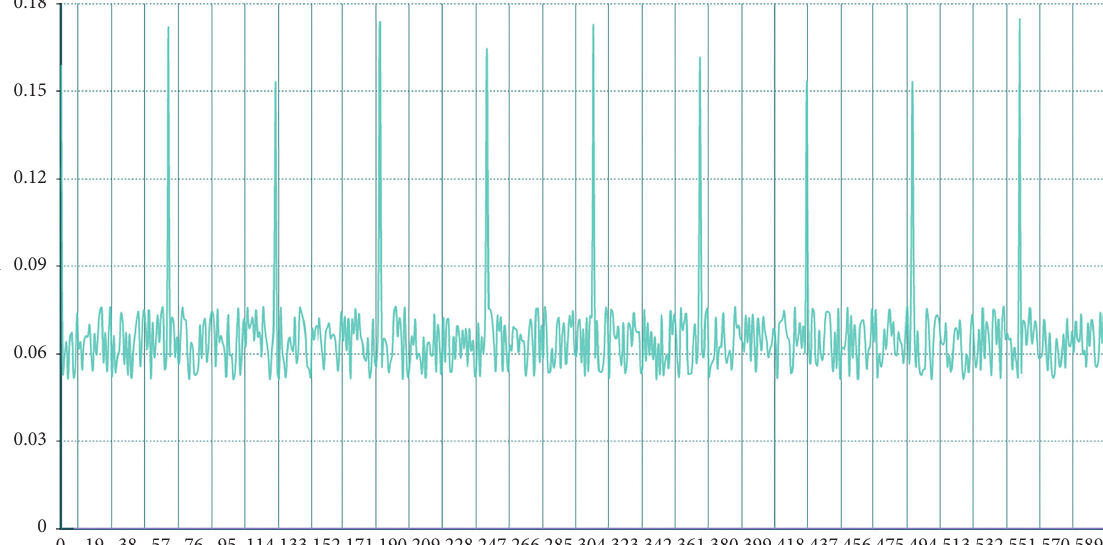
Figure 7: Instantaneous power consumption of the system.